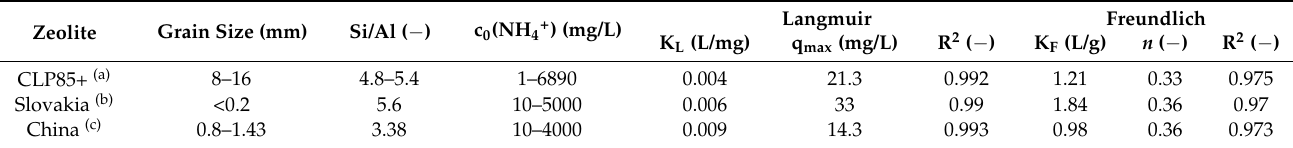
Table 3. Experimental isotherm constants compared to other studies.